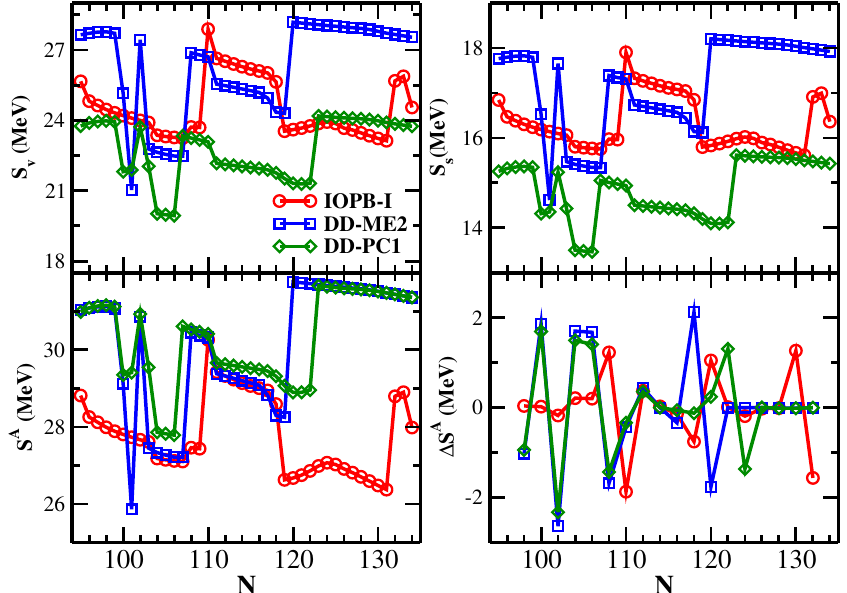
Figure 5. (Color online) Same as Figure 4, but for the existing isomeric states of Hg-isotopes. Since the conventional Brückner energy density functional (B-EDF) fails in Figure 4 to reveal a conspicuous peak in the symmetry energy at N = 126, indicating the presence of a closed shell/sub-shell as presented in Ref. [9]. We therefore employ the effective theory mo- tivated relativistic energy density functional (E-RMF) which has been recently shown [54] to resolve the Coester band problem [55–57]. Here, we have shown the calculations of symmetry energy S A for the ground states of Hg-isotopic series with NL3 set [24] as a representative case. Figure 6 shows a relative comparison between the prediction of the B-EDF and E-RMF using the NL3 parameter set. Unlike the B-EDF, a notable peak is formed along with the symmetry energy S A Hg-isotopic chain at N = 126 as well as its isotopic shift ∆ S A . In addition to the fluctuations, the component S V and S S combines to give S A